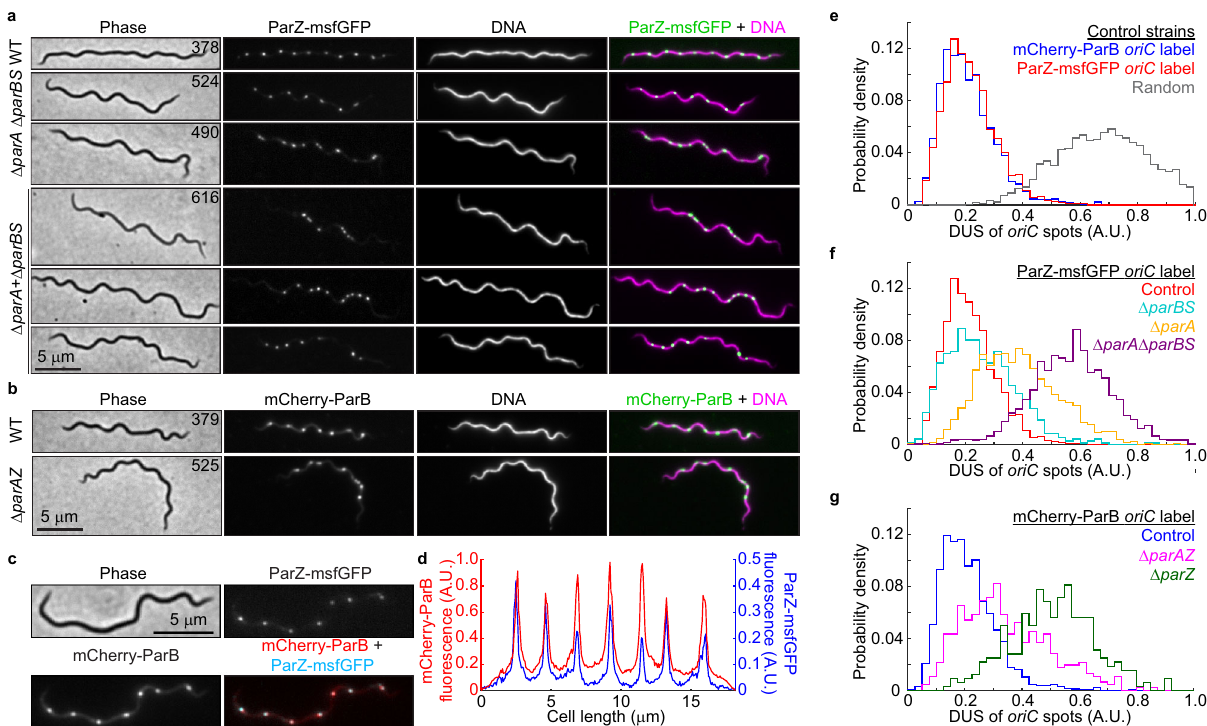
Fig.8|ParZisanovelbacterialcentromere-bindingproteinthatcontributesto oriC segregation. a Images of ParZ-msfGFP signal in strains carrying the full complement of B.burgdorferi par genes (WT)or lacking the par genes and/or parS sequence as indicated. DNA was stained with Hoechst 33342. CJW_Bb strain num- bers are listed on the phase-contrast images. b Images of mCherry-ParB signal in strains carrying the full complement of par genes (WT) or lacking the parAZ operon,asindicated.DNAwasstainedwithHoechst33342.CJW_Bbstrainnumbers are listed on the phase contrast images. c Images of strain CJW_Bb403 showing colocalization of ParZ-msfGFP and mCherry-ParB signals. d Fluorescence intensity pro fi le along the cell length for the cell shown in ( c ). e Histograms showing the distributions ofdeviations from uniform spacing (DUS, see methods) of oriC spots